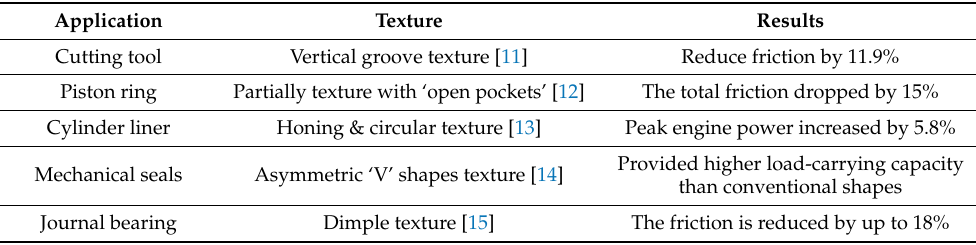
Table 1. Application of surface texture in practical